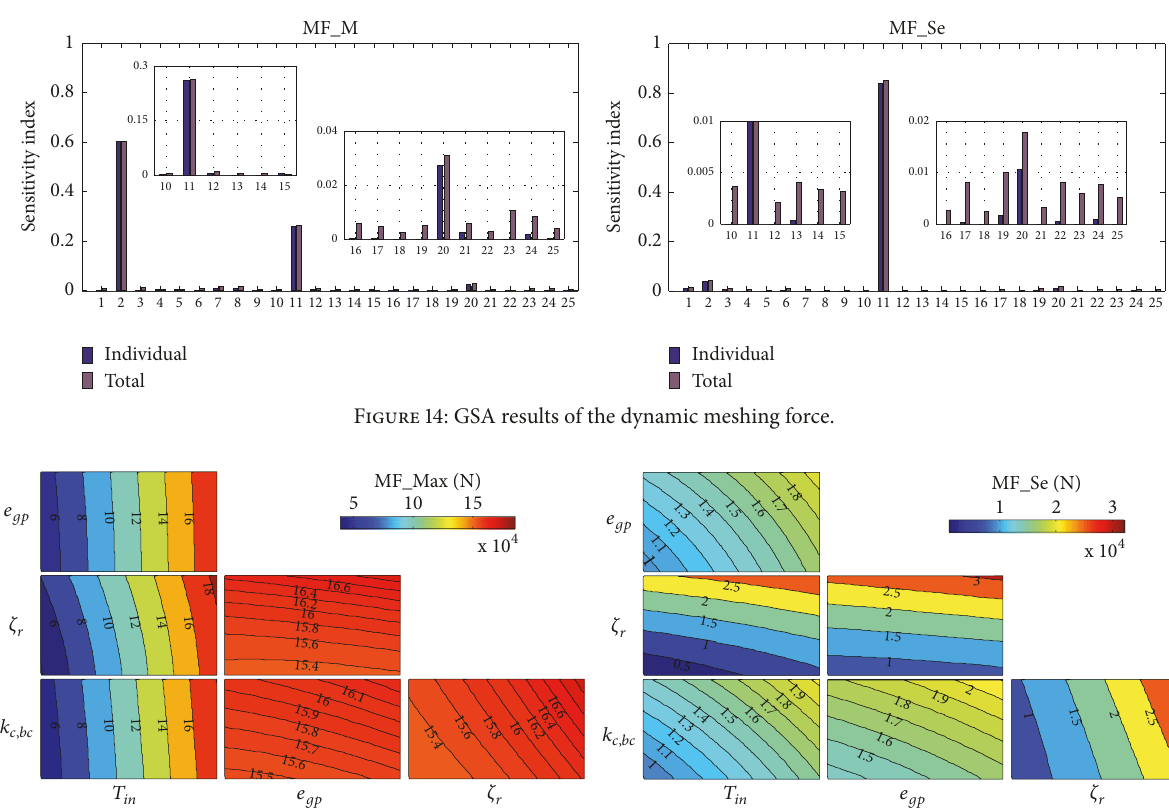
Figure 13: GSA results of the vibration acceleration in three directions.